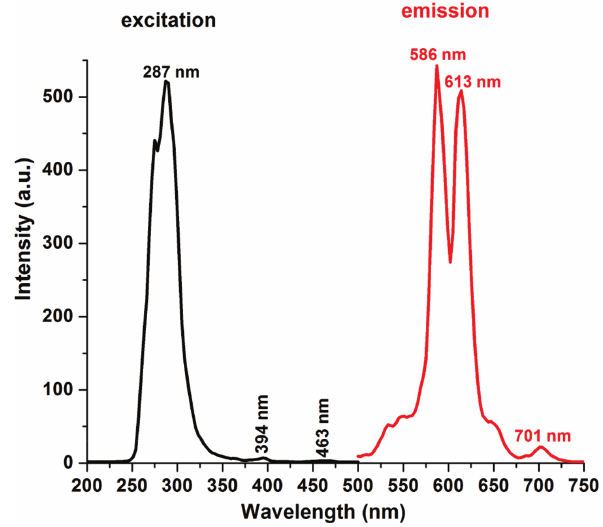
Figure 8: The PL spectra of Sr 3 SiO 5 :Eu 3+ , Dy 3+ , Mg 2+ system phosphor.